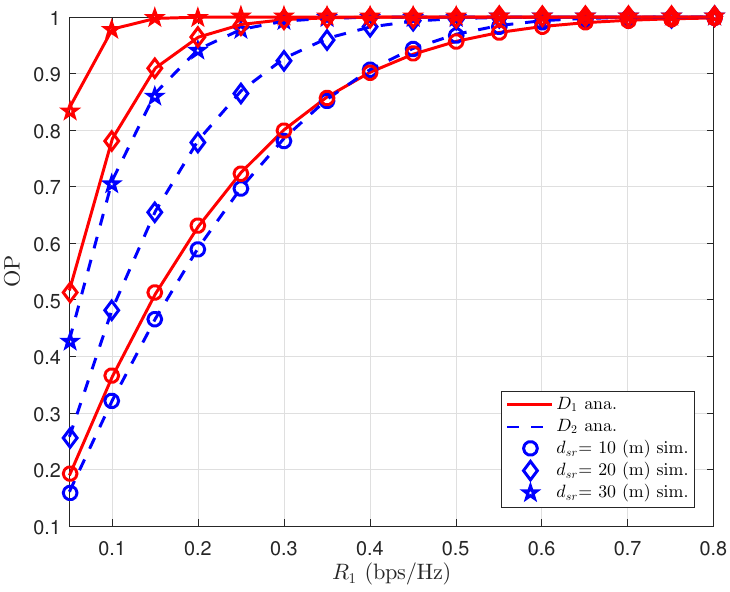
Figure 5. OP versus R 1 = R 2 for different d sr .